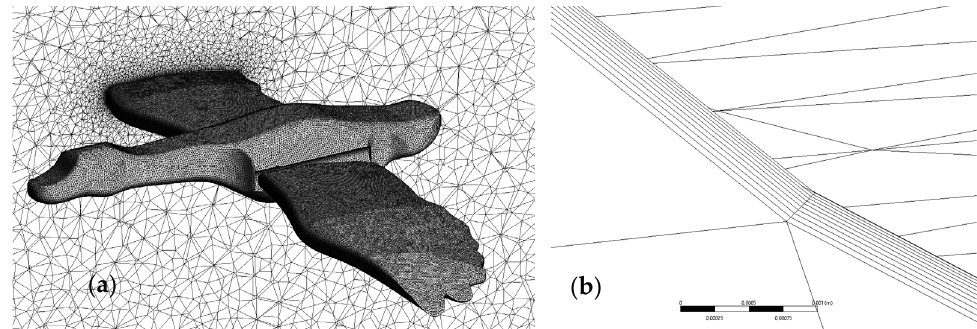
Figure 2. ( a ) Surface mesh on the bird’s body and in a 2D vertical plane intersecting a wing of the bird; ( b ) a detailed view of the inflation mesh around the wings.